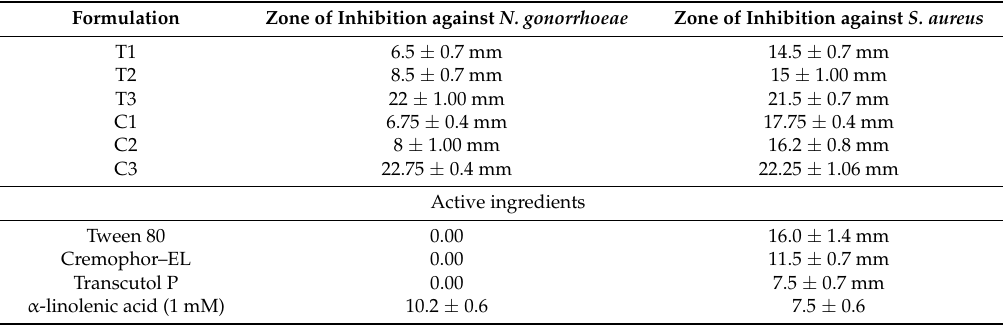
Table 2. Growth inhibition zone diameter of three selected α -linolenic acid based ME formulations